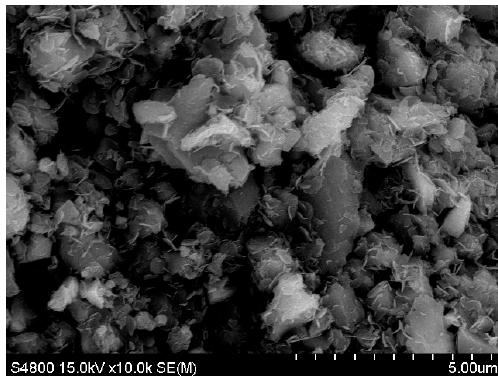
Figure 2. SEM image of BOFS after grinding.